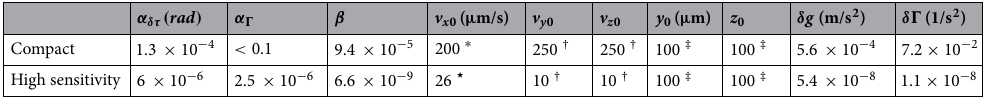
Table 2. Requirements on the pointing of the relaunch, starting parameters, variation of gravitational acceleration, and its gradient. The parameters are calculated to induce contributions (see Eqs. 5 to n below the shot-noise limit ( 1 / √ N ) for the scenarios in the lower rows of 14) by a factor of 10 · 10ns for a typical experiment control system 31 , Earth’s gravity gradient Table 1. We assume δτ =